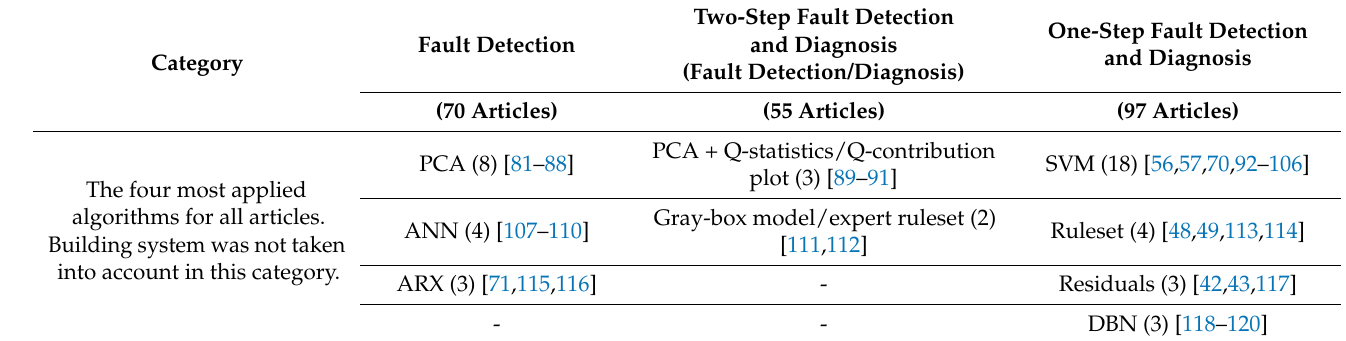
Table 6. Fault detection (FD) and one- and two-step FDD methods used in all the articles. Two-Step Fault Detection One-Step Fault Detection Fault Detection and Diagnosis and Diagnosis Category (Fault Detection/Diagnosis) (70 Articles) (55 Articles) (97 Articles) The four most applied algorithms for all